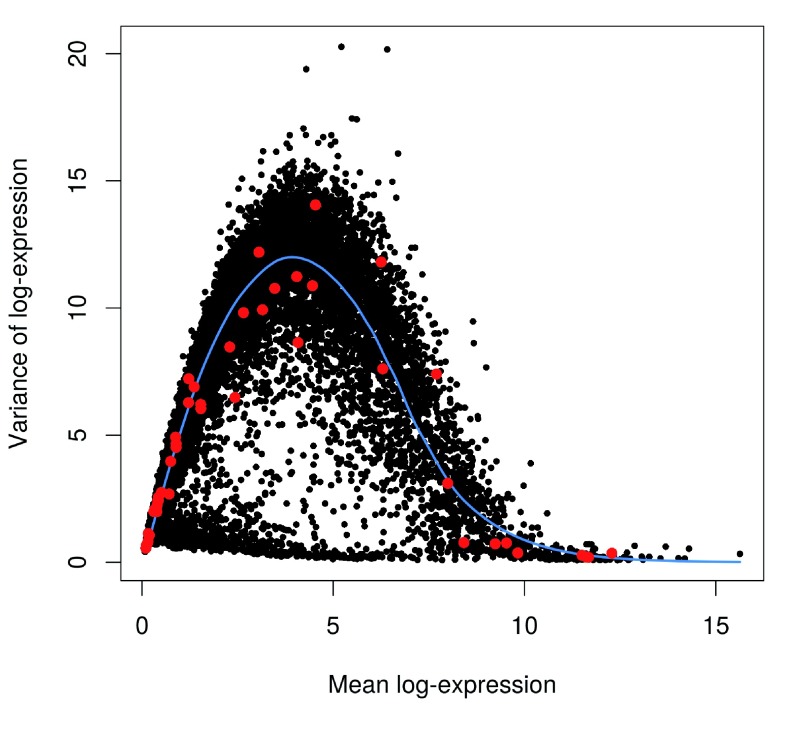
Variance of normalized log-expression values for each gene in the HSC dataset, plotted against the mean log-expression.The blue line represents the mean-dependent trend fitted to the variances of the endogenous genes. Variance estimates for spike-in transcripts are highlighted in red.